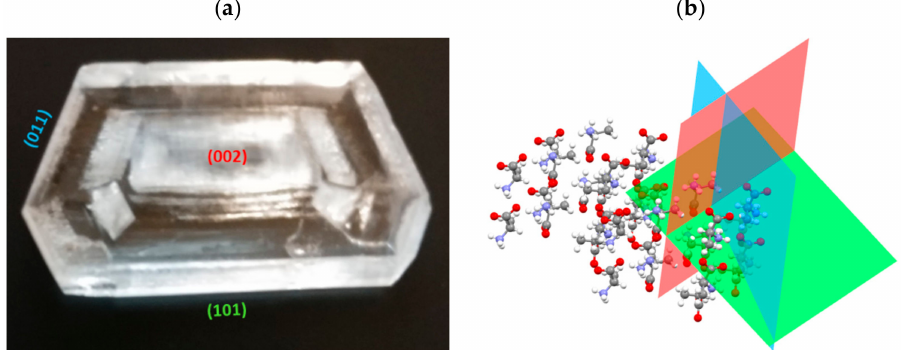
Figure 1. ( a ) Photo of the L-alanine single crystal and measured planes. ( b ) L-alanine crystal structure showing measured planes, obtained in simulation using Mercury. Green, red, and blue represent the (101), (002), and (011) planes,